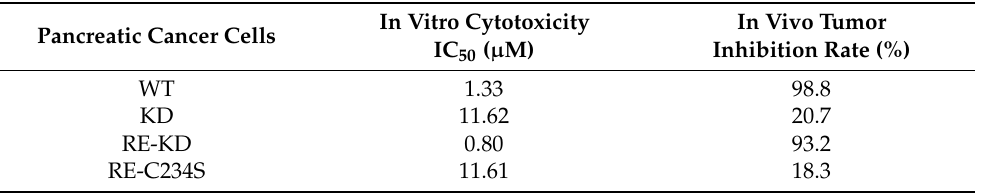
Table 2. In vitro cytotoxicity of 33 against different types of pancreatic cancer cells (WT, KD, RE-KD, RE-C234S) and its in vivo anticancer efficacy in the corresponding mouse xenograft models [130]. Pancreatic Cancer